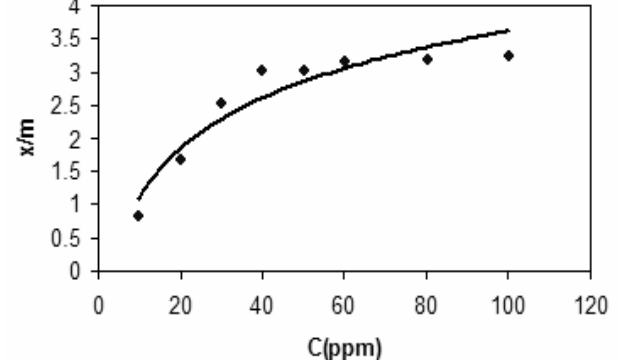
Figure 5 . Effect of initial concentration on the removal of lead ion by PANi/SD. The adsorption experimental conditions and calculations were as described in Figure